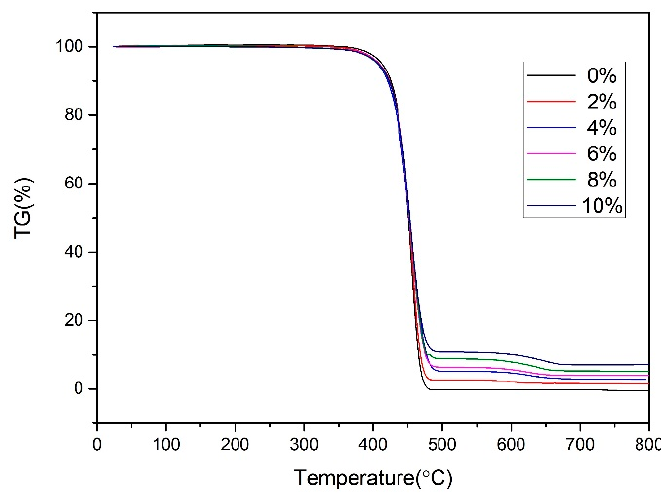
Figure 5. Thermogravimetric analysis (TGA) curves of nanocomposites. Table 2. Comparison of Thermogravimetric analysis (TGA) properties of nanocomposites.